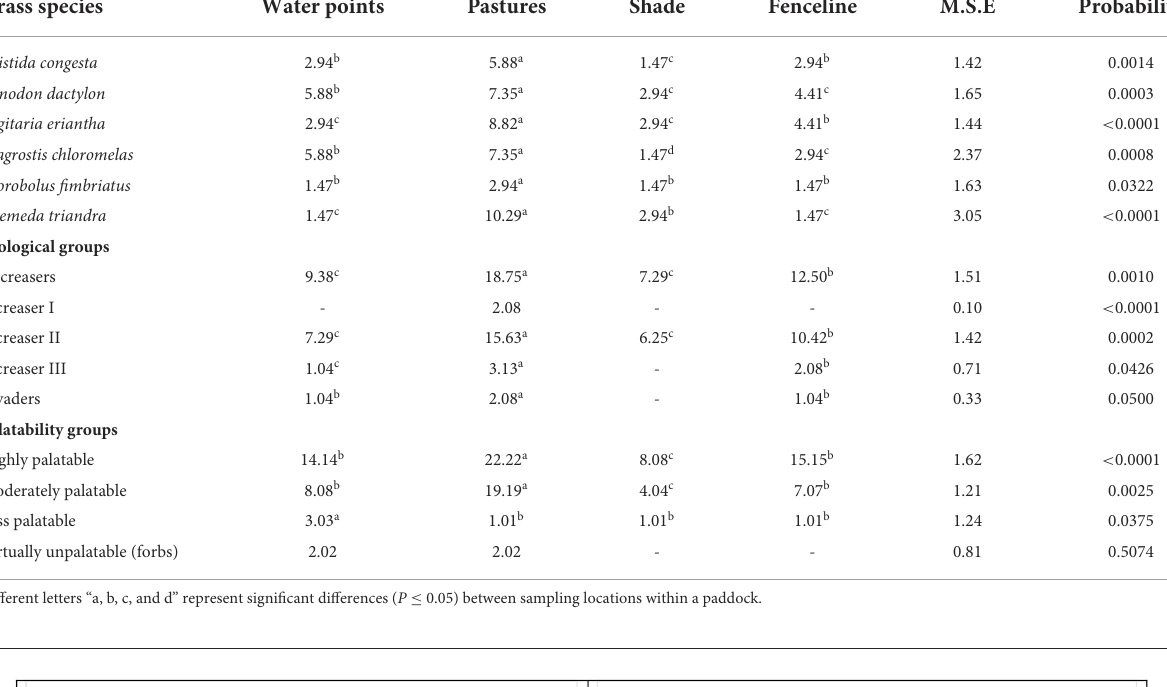
time spent along fenceline. BR spent more ( P < 0.0001) time along water points than NG. A variation in time spent along water sources was more dominant ( P < 0.0001) in Weeks 1–3